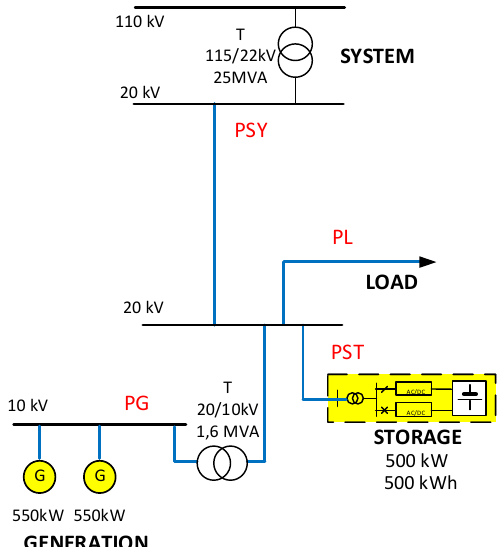
Figure 2. Diagram of the analyzed active grid. PG—power generation, PL—load, PSY—power distribution system, PST—BESS.